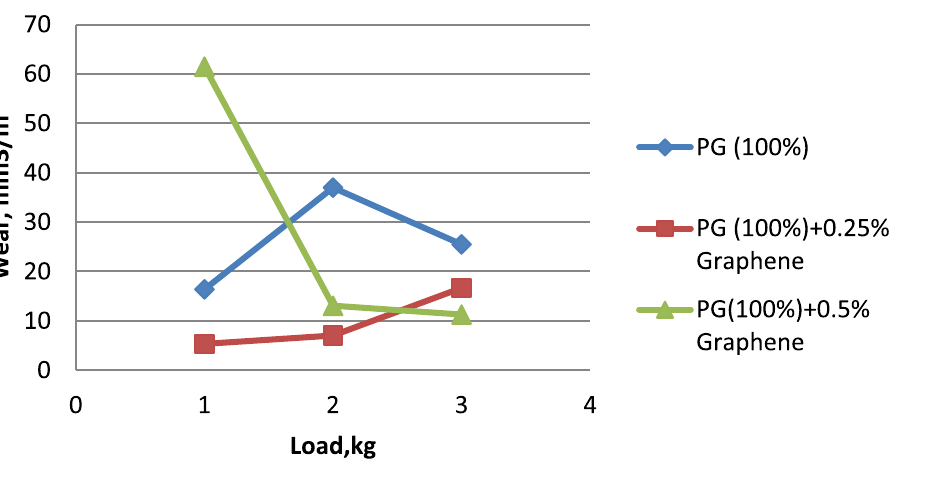
Figure 4. Load vs. wear rate for propylene glycol